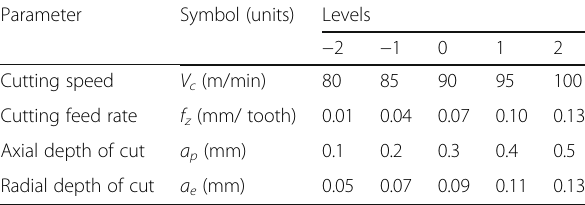
Table 2 Parameters and their levels in ball nose milling